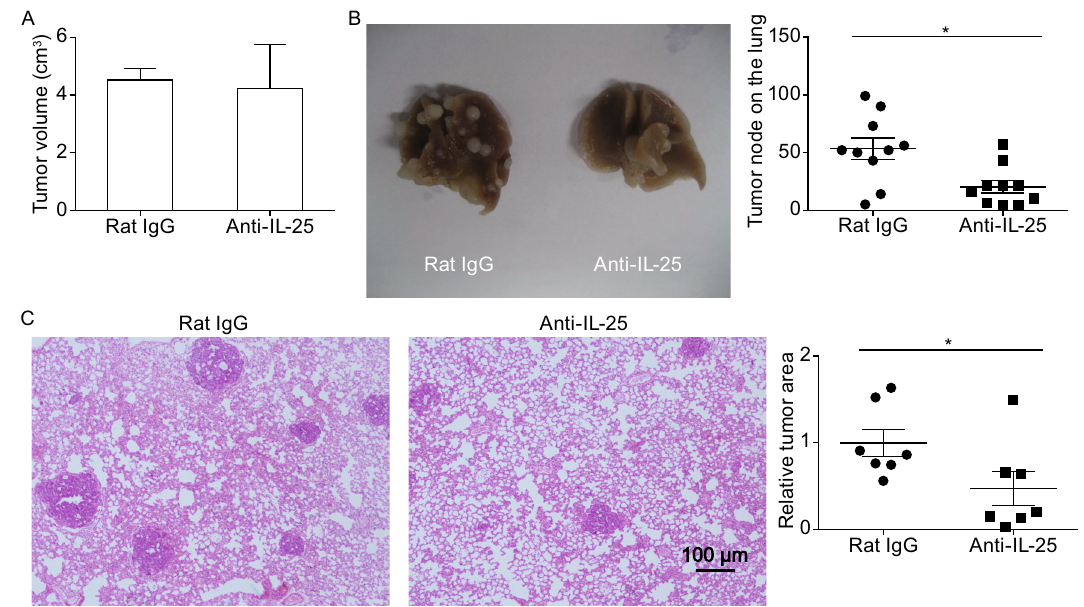
Figure 2. Anti-IL-25 blocking antibody reduced lung metastasis. The MMTV-PyMT mice were treated with either anti-IL-25 antibody or isotype control antibody starting from 4 – 5 weeks old, and sacri fi ced at 14 weeks old. (A) The size of primary tumors (mean ± SE). (B) Representative images of lung tissues isolated from the MMTV-PyMT and WT mice. The numbers of tumor nodes on the surface of lungs were shown as mean ± SE. (C) Representative H & E staining images of the lung tissues isolated from the MMTV-PyMT mice treated with either Rat IgG or anti-IL-25 antibody (×10 magni fi cations). The relative tumor areas were shown as mean ± SE and analyzed by Student ’ s t